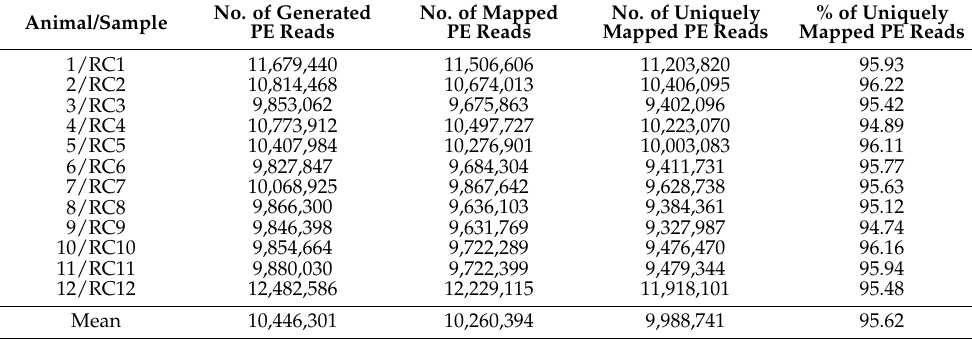
Table 3. Total number of generated PE reads aligned to the reference genome, and total number and percentage of uniquely mapped PE reads in samples collected from G1 animals (no creep feeding) at weaning. Animal/Sample No. of Generated PE Reads No. of Mapped PE Reads No. of Uniquely Mapped PE Reads % of Uniquely Mapped PE Reads